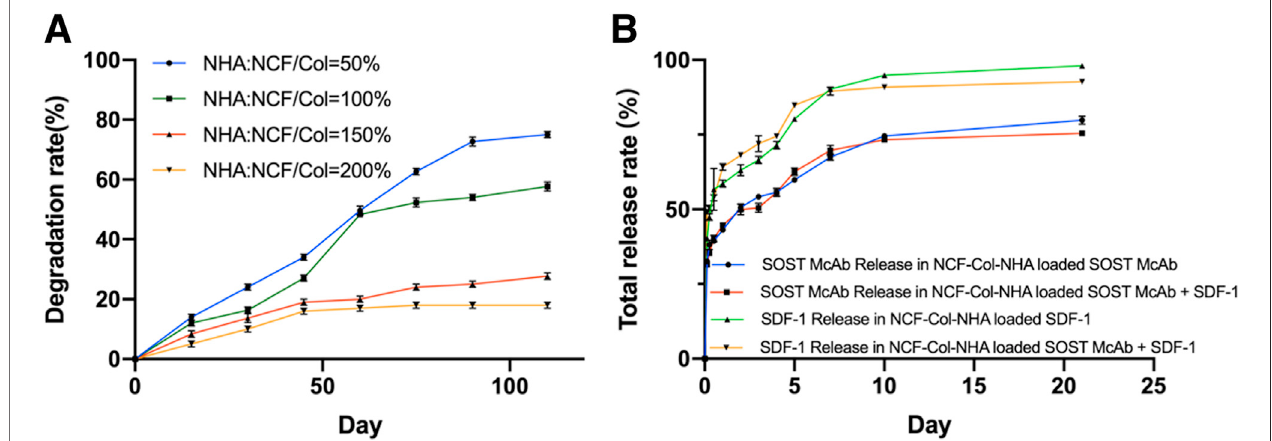
FIGURE 2 | The degradation curve and drug release curve of the NCF-Col-NHA aerogel scaffolds in vitro . (A) In vitro degradation curve of NCF-Col-NHA aerogel scaffolds with different NHA content. The less NHA content, the faster the material degrades (B). Drug release curve of aerogel scaffolds loaded with different drugs. There was no difference in release rate between SOST McAb and SDF-1, whether co-loaded or individually loaded on aerogel